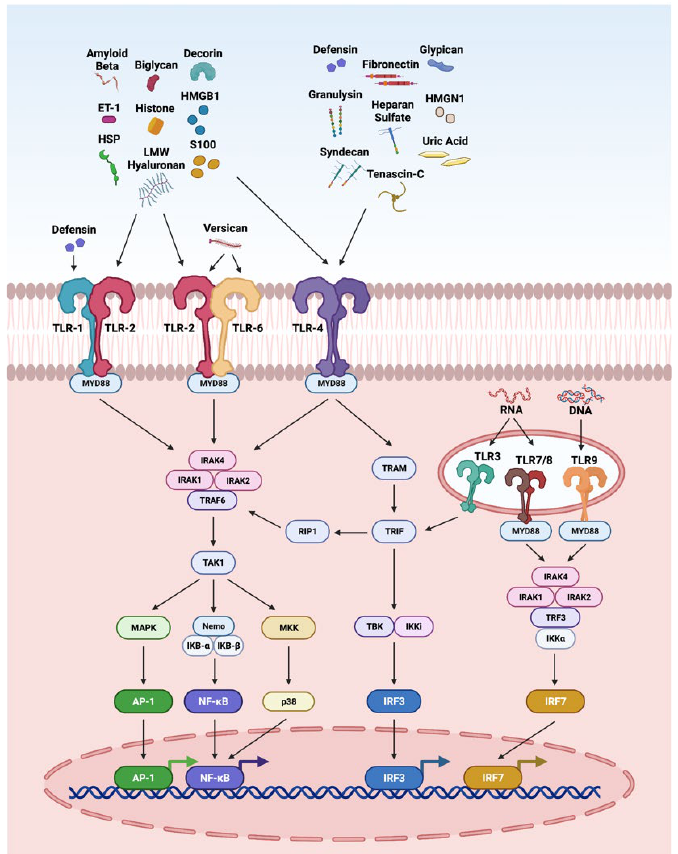
Figure 2. Overview of DAMPs activating the toll-like receptor (TLR) pathways. TLRs recognize a variety of DAMPs. Defensin activates TLR1; biglycan, decorin, versican, LMW hyaluronan, S100, HSP, Aβ, histones, HMGB1, and ET-1 activate TLR2; biglycan, decorin, LMW hyaluronan, HS, fibronectin, tenascin-C, S100, HSP, uric acid, Aβ, histones, HMGB1, HMGN1, ET-1, defensins, granulysin, syndecan, and glypican are reported to activate TLR4; versican activates TLR6; RNA activates TLR3, 7 and 8; and DNA activates TLR9. When TLRs are stimulated by DAMPs they dimerize and recruit downstream adaptor molecules, such as myeloid differentiation primary-response protein 88 (MyD88), and TRIF-related adaptor molecule (TRAM), which directs downstream molecules, leading to the activation of signaling cascades that converge at the NFκB, activator protein 1 (AP1), and interferon response factors (IRFs).